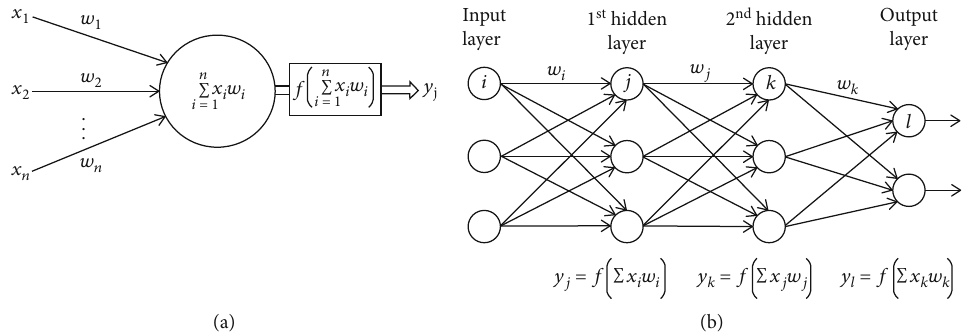
Figure 8: Representation of the layer-wise structure of the neural network [57].